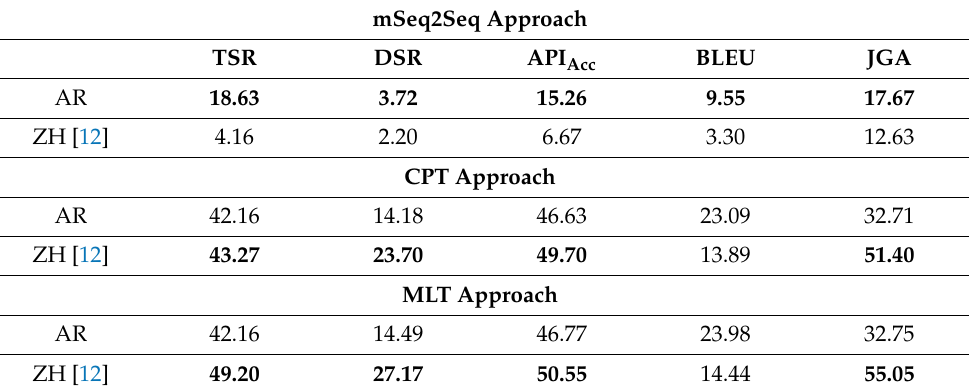
Table 2. Cross-lingual experiment results of dialogue state tracking (DST) and end-to-end dialogue generation with 10% of Arabic-TOD dataset (AR) compared to 10% of Chinese dialogues in BiToD (ZH) [12]. Bold numbers indicate the best result according to the column’s metric value.